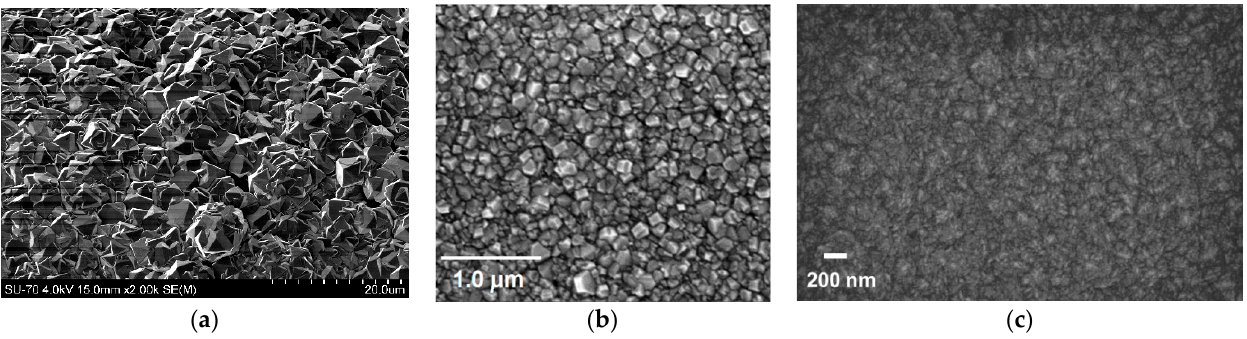
Figure 2. SEM micrographs showing the morphology of: ( a ) microcrystalline diamond; ( b ) nanocrystalline diamond (NCD); ( c ) ultrananocrystalline diamond (UNCD). Figure 2b is reprinted with permission of Elsevier from Diamond and Related Materials, Vol. 15, O.A. Williams, M. Daenen, J. D’Haen, K. Haenen, J. Maes, V. Moshchalkov, M. Nesládek, D.J. Gruen, Comparison of the growth and properties of ultrananocrystalline diamond and nanocrystalline diamond, pp. 654–658 [23], ©Elsevier, 2006. Figure 2c is reprinted with permission from Sumant, A.; Grierson, D.; Gerbi, J.; Carlisle, J.; Auciello, O.; Carpick, R., Physical Review B, 76, 235429, 2007, © American Physical Society, 2007 [24] .